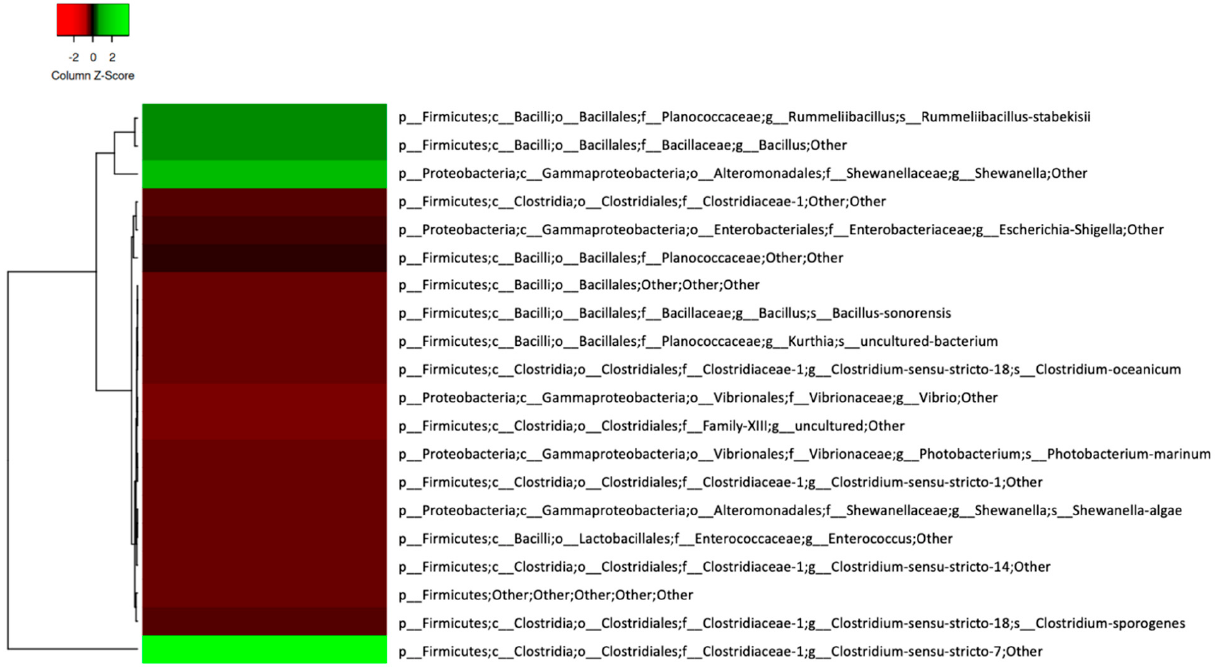
Figure 8. A heat map showing the taxonomy assignment for each OTU. Green color represents OTUs having relatively higher abundance whereas red color represents OTUs having lower abun- dance. (For interpretation of the references to color in this figure legend, the reader is referred to the web version of this article).